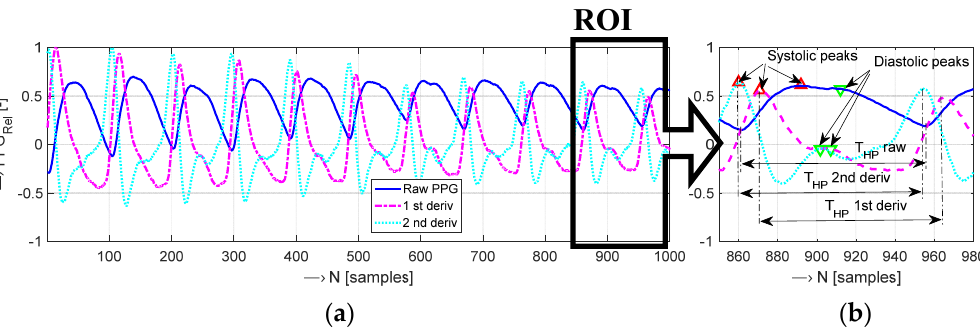
Figure 1. Example of three basic types of photoplethysmograms: ( a ) 1-k sample of the raw photo- plethysmogram together with its first/second derivatives, ( b ) detailed 100 sample ROI around the 10th PPG cycle together with determined maxima corresponding to systolic and diastolic peaks and a denoted heart pulse period T HP .